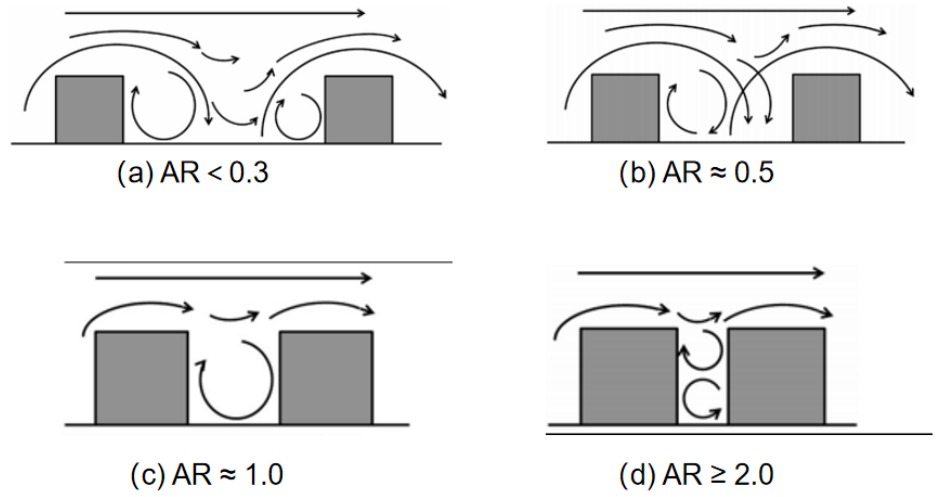
Figure 2. ( a – d ) The flow regimes in canyons for different aspect ratios under isothermal conditions. Adapted with permission from Ref. [138]. 2020, Elsevier.